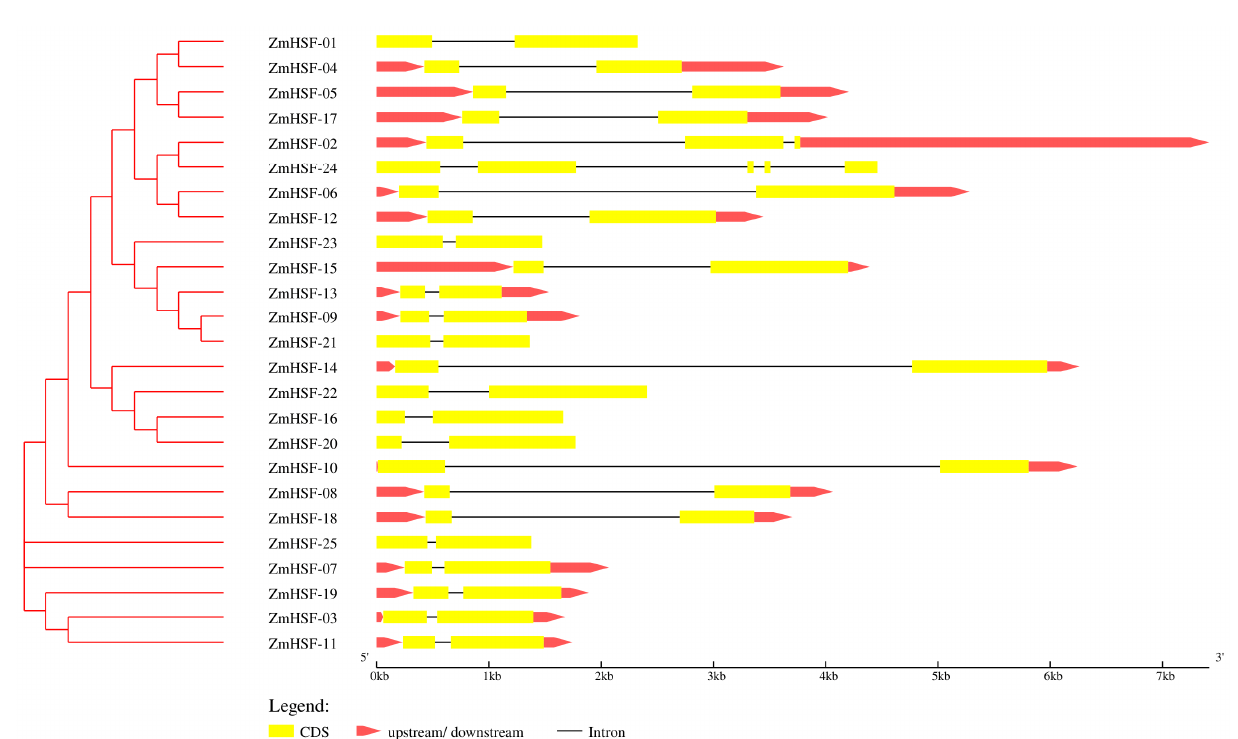
Figure 4. The intron–exon structure of maize HSF genes. A black line represents the introns. Exons are represented by a yellow rectangle and 5 ′ UTR and 3 ′ UTR by reddish-pink wedges. The gene structure of Zea mays HSFs was in alignment with the phylogenetic relationship.